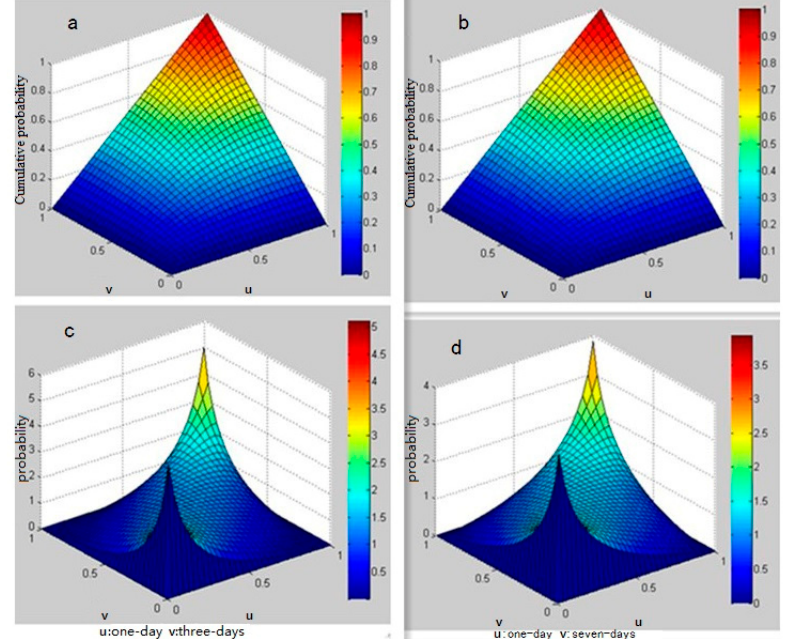
Figure 5. Three-dimensional plots for the theoretically fitted Gumbel copula. ( a ) fitted copula using a shaded surface of one-day and three-day; ( b ) fitted copula using a shaded surface of one-day and seven-day; ( c ) upper tail correlation of one-day and three-day; ( d ) upper tail correlation of one-day and seven-day.